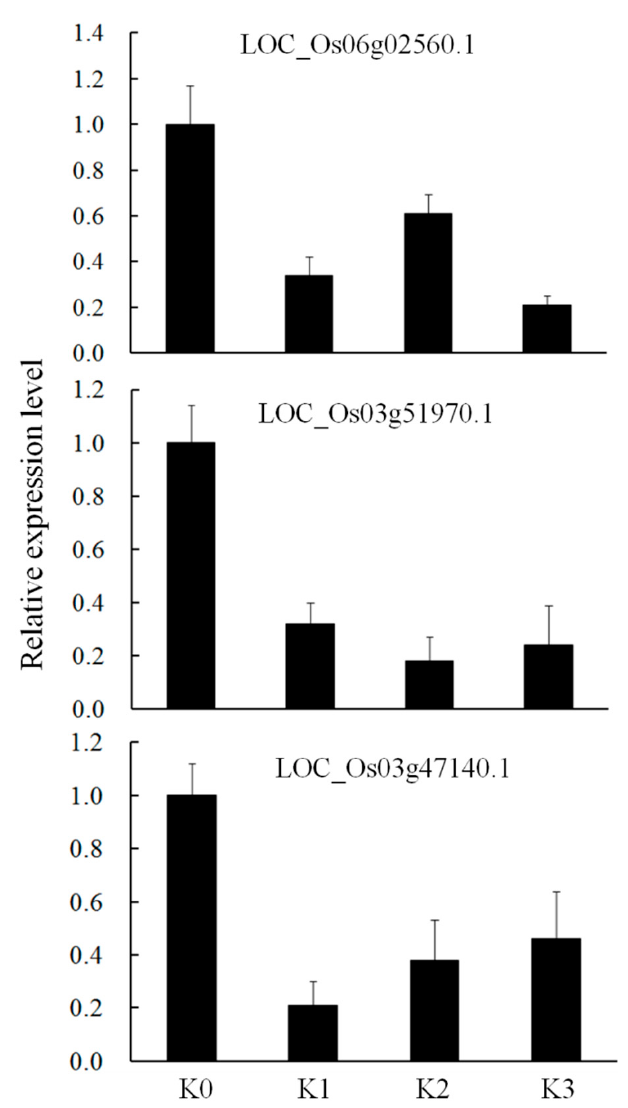
Figure 6. The expression levels of three targets OsGRFs of osa-miR396f analyzed by qRT-PCR in an incompatible interaction. Data represent means of three replicates ± standard deviation for each target in the four miRNAs libraries from an incompatible interaction.